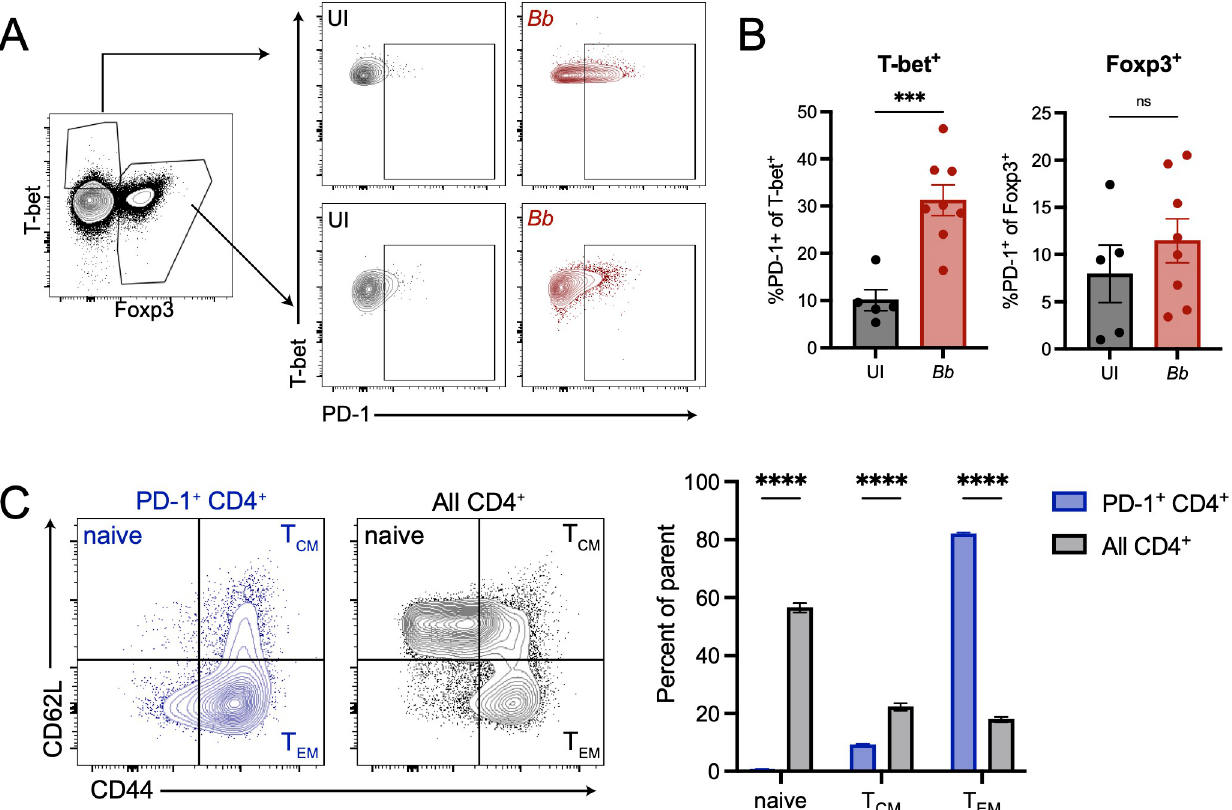
Fig 4. PD-1 upregulation is primarily found on T-bet + CD4 + T cells and not Foxp3 + CD4 + T cells. WT mice were inoculated with B . burgdorferi or media alone and sacrificed at four weeks post-infection. Popliteal lymph nodes were harvested and CD4 + T cells were assessed by flow cytometry for expression of (A, B) Foxp3 and T-bet through gating on live ➔ CD3 + ➔ CD4 + ➔ Foxp3 + or T-bet + cells followed by PD-1 + gating. (C) Popliteal lymph nodes were separately harvested and PD-1 + CD4 + T cells (blue) and total CD4 + T cells (gray) were assessed for effector memory (T EM ), central memory (T CM ) or na ï ve status based on CD44/CD62L staining. Data are representative of two independent experiments with at least 5 mice per group and were analyzed using (B) unpaired t test or (C) two-way ANOVA with Sidak’s multiple comparisons test.